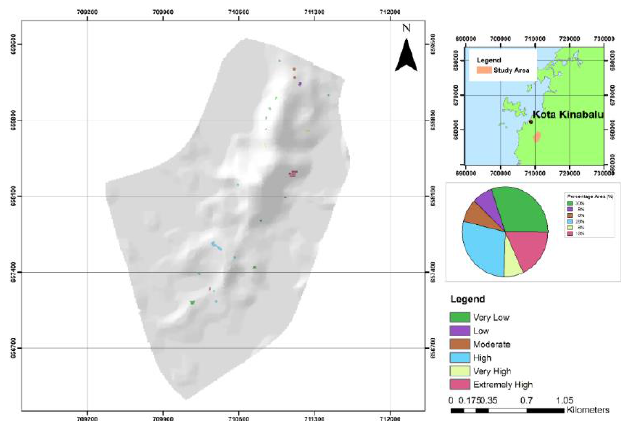
Figure 10: Total Landslide Vulnerability Assessment (LVAs) map of the study